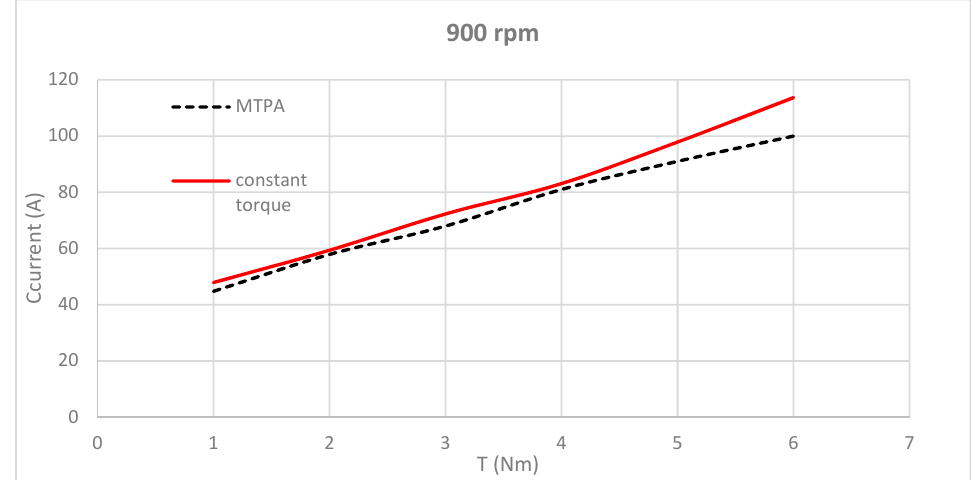
Figure 11. Hardware-in-the-loop (HIL) and the related circuits for experiments. Figure 13. Hardware-in-the-loop (HIL) and the related circuits for experiments. Electronics 2018 , 7 , x FOR PEER REVIEW